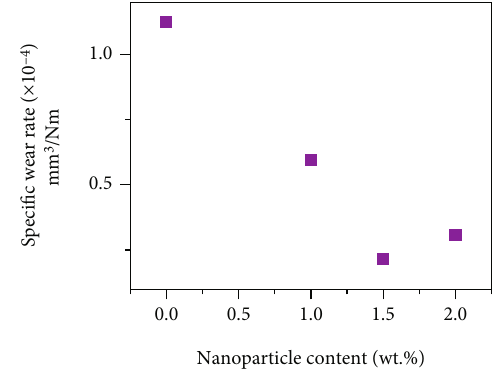
Figure 10: Speci fi c wear rate for the CSM glass and nanographite reinforced epoxy